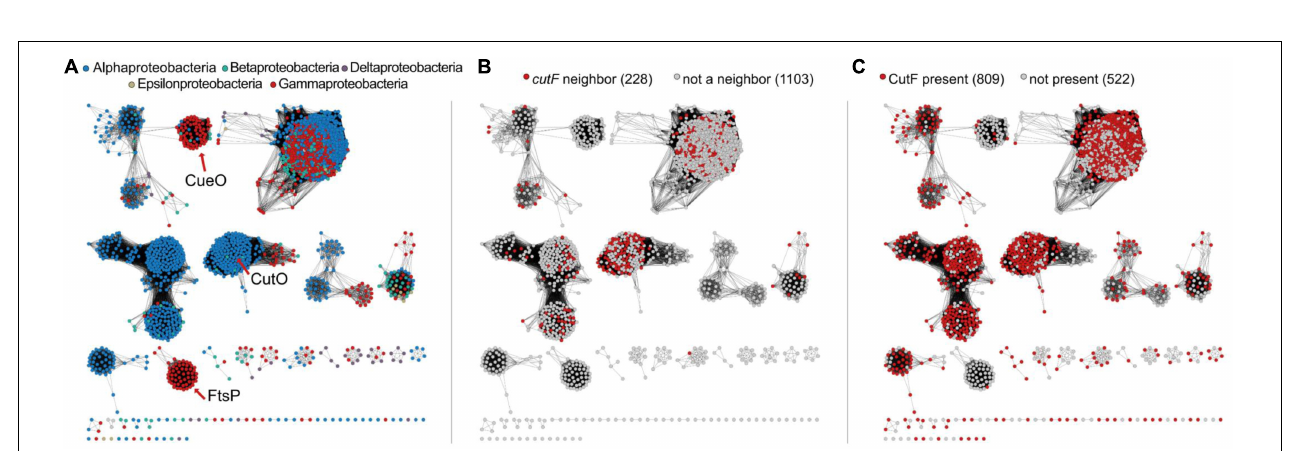
FIGURE 8 | Sequence similarity networks of Cu-oxidase-like proteins. (A) network representing sequences containing Pfam domains PF00394, PF07731, and PF07732 from Uniprot-designated reference proteomes in the proteobacterial lineage. Nodes are colored according to the legend shown in each panel. The location of nodes representing CueO and FtsP from E. coli and CutO from R. capsulatus are indicated with red arrows. (B) Nodes are colored as to whether cutF is a neighbor of the Cu-oxidase-encoding gene. (C) Nodes are colored based on whether CutF is encoded in the genome or not. For panels (B,C) , numbers in parentheses on top of each panel represent the number of nodes in the